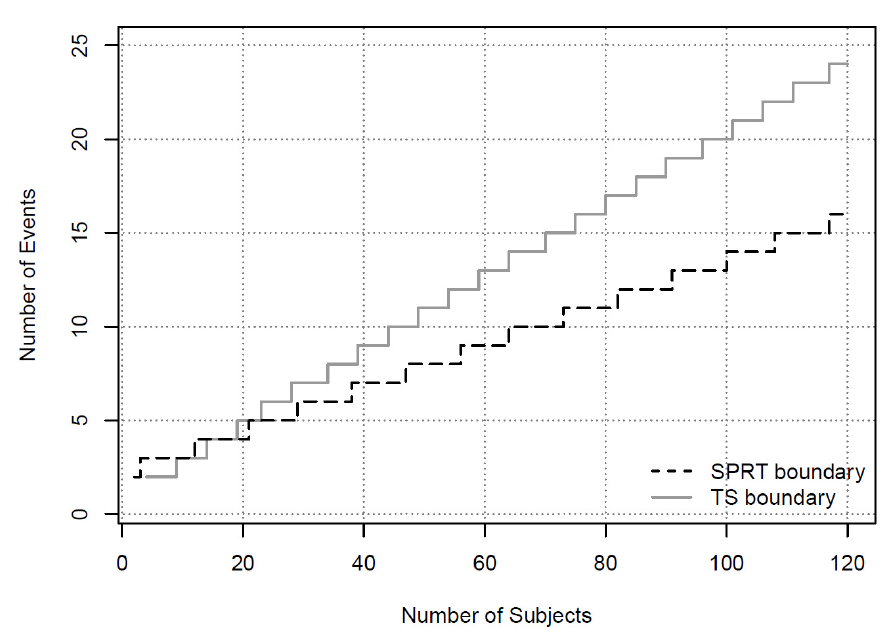
Figure 1. Safety Boundaries Using Blinded